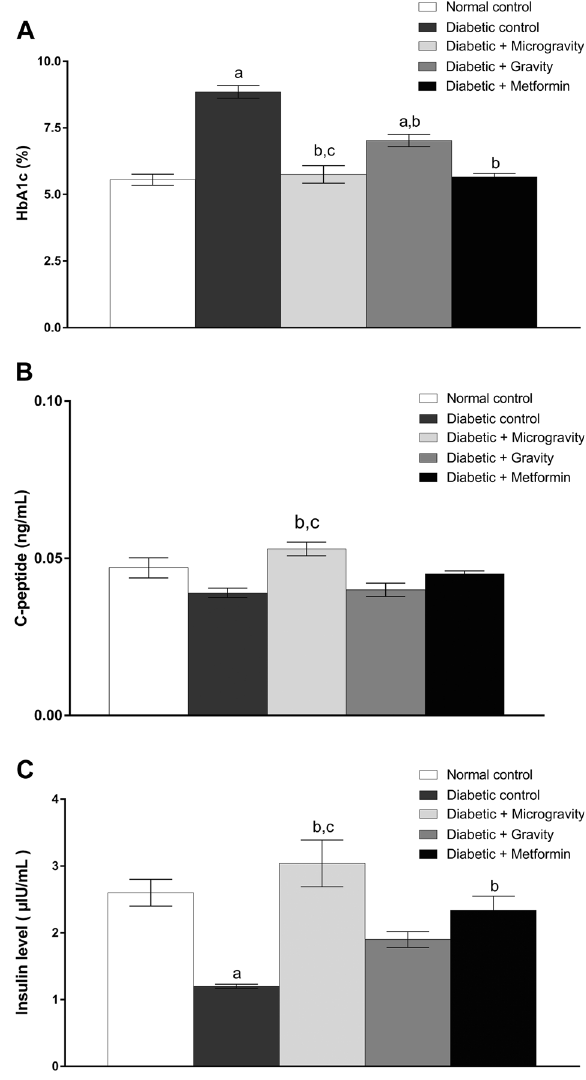
Fig. 4 Effect of treatment with ethanolic extracts of T. aestivum under gravity and microgravity conditions for 30 days on C-peptide, serum insulin, and glycated hemoglobin (HbA1c) levels in experimental rats. a shows the effect of ethanolic extracts of T. aestivum germinated under gravity and microgravity conditions on body weight in experimental rats. b shows the effect of ethanolic extracts of T. aestivum germinated under gravity and microgravity conditions on C-peptide levels in experimental rats. c shows the effect of ethanolic extracts of T. aestivum germinated under gravity and microgravity conditions on serum insulin levels in experimental rats. The values are expressed as the mean ± SEM of seven rats in each group. Data were analyzed by using two-way ANOVA, followed by Tukey ’ s multiple comparison test with the level of signi fi cance set at P < 0.05. a refers to treatment versus normal control, b refers to treatment versus diabetic control, and c refers to microgravity versus